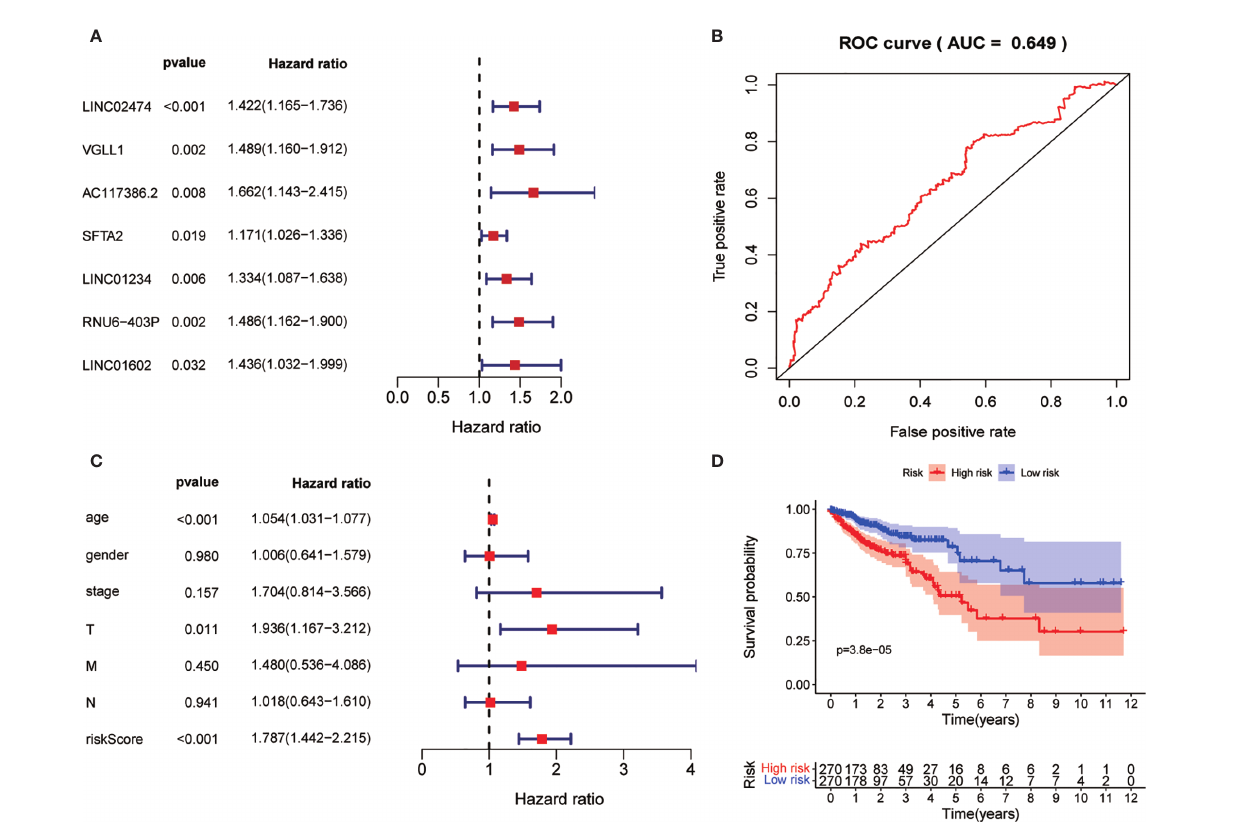
FIGURE 8 | Non-ARG gene prediction model. (A) Forest plot of Univariate COX analysis. (B) Forest plot of multi-factor independent prognostic analysis. (C) Non- ARG gene prediction model ROC validation curve. (D) Survival